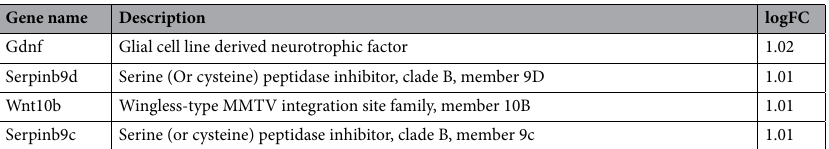
Table 2. EPS up-regulated genes annotated with the GO term extracellular region.